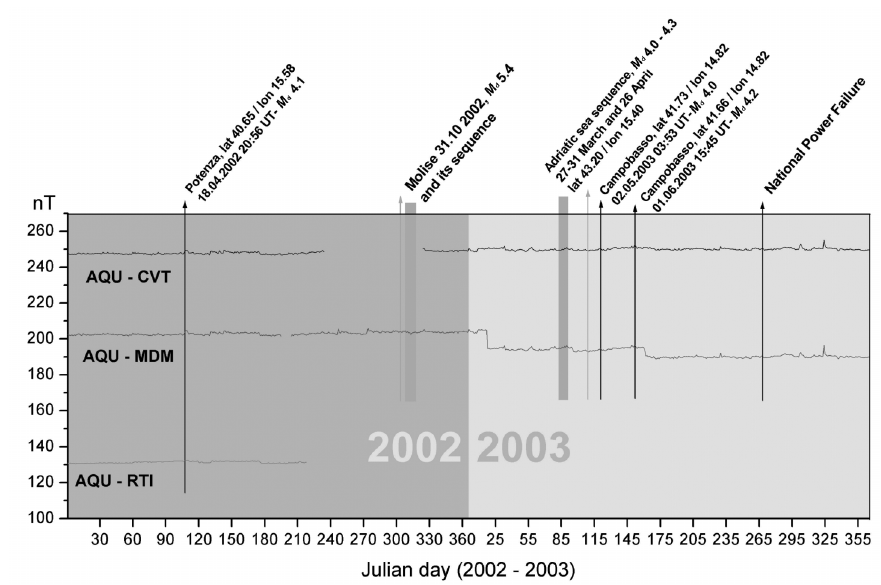
Fig. 4. Daily differences (in nT) between couples of stations and main seismic events occurred in 2002 and 2003 in an area extending 41° and 43° in latitude and 12° and 15° in longitude. Vertical bands indicate the Molise earthquake ( M = 5.4) and its sequence occurred at the end of October 2002 and the Adriatic Sea sequence of March- April 2003. National power blackout event occurred on September 28, 2003 at 03:01 is also reported on